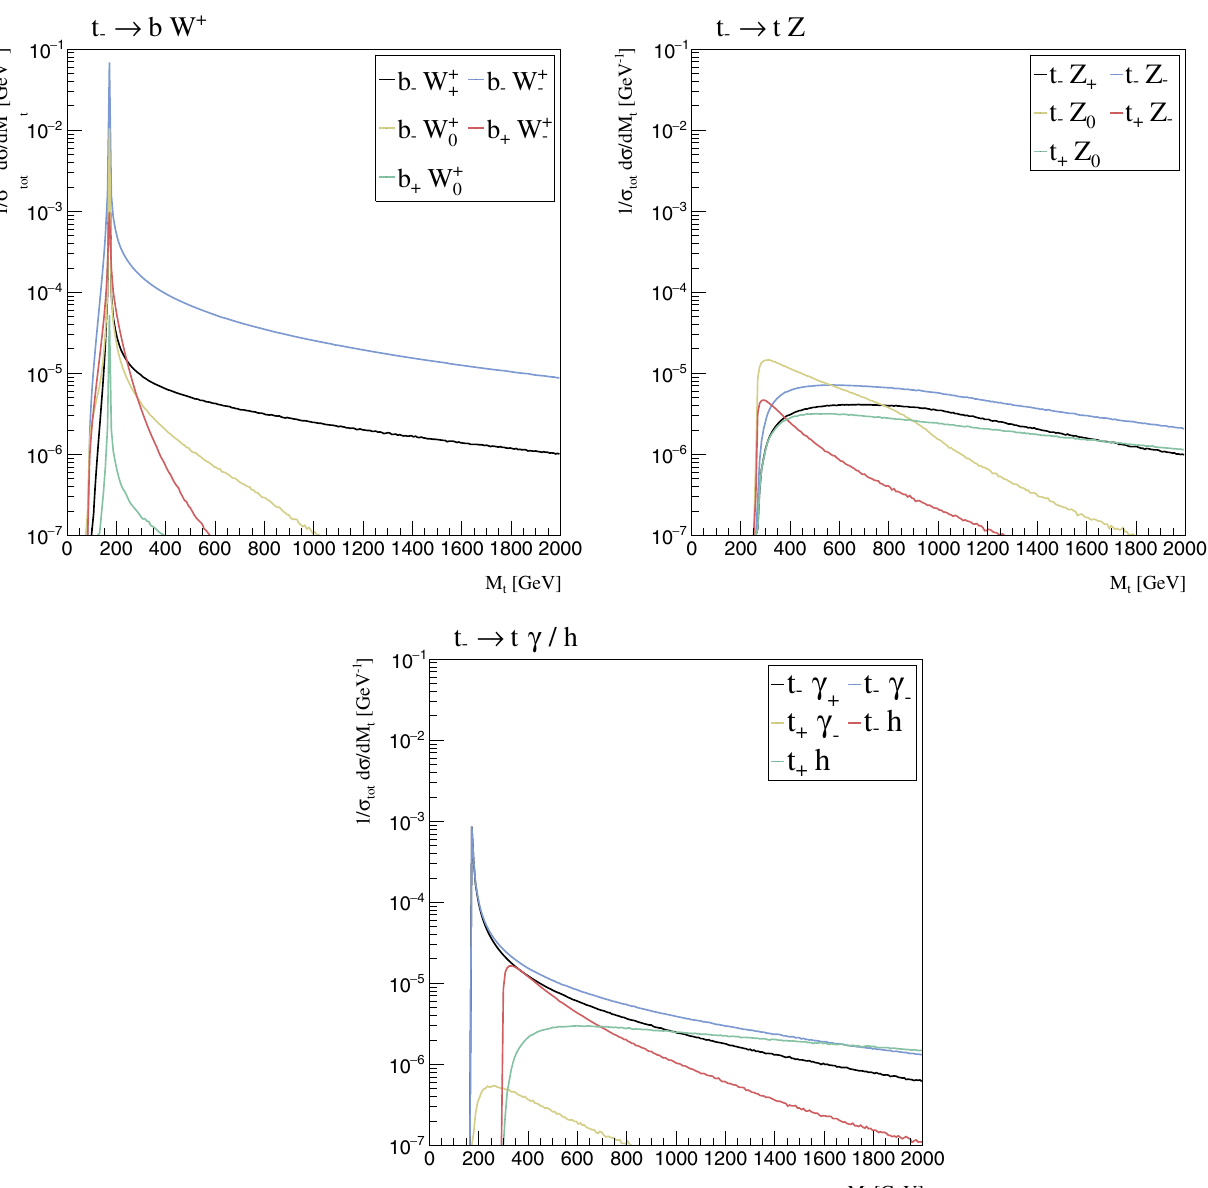
Fig. 2 Branching spectra of a 1 TeV top quark to bW + (left), tZ (right) and t γ/ h (bottom)